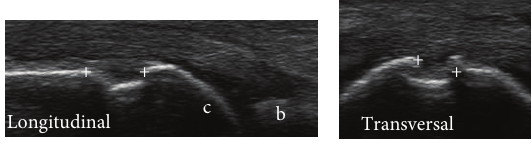
Figure 1: Erosion in the 2nd MCP joint from dorsal.